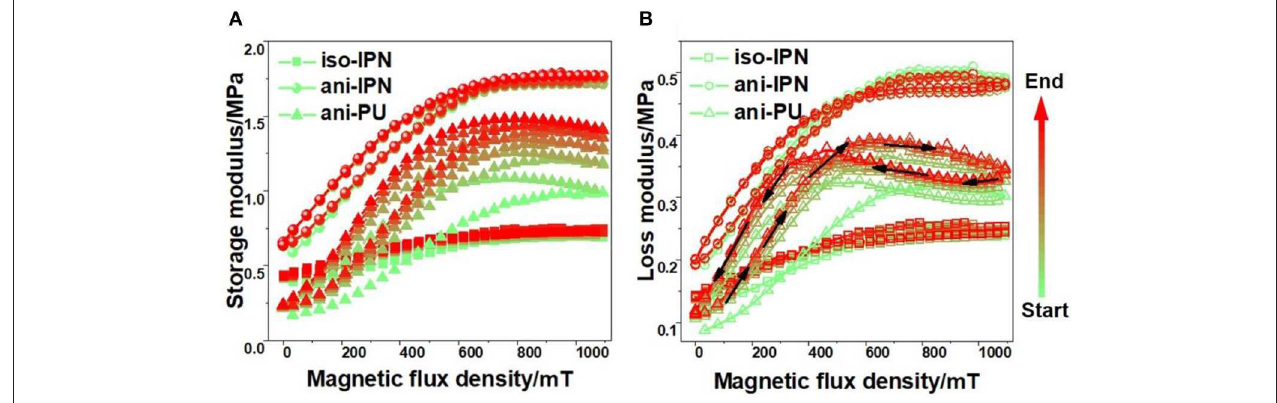
FIGURE 4 | Dynamic modulus ( A : storage modulus; B : loss modulus) as a function of the triangular magnetic field. The change of loss modulus is denoted by the direction of the black arrow in (B)